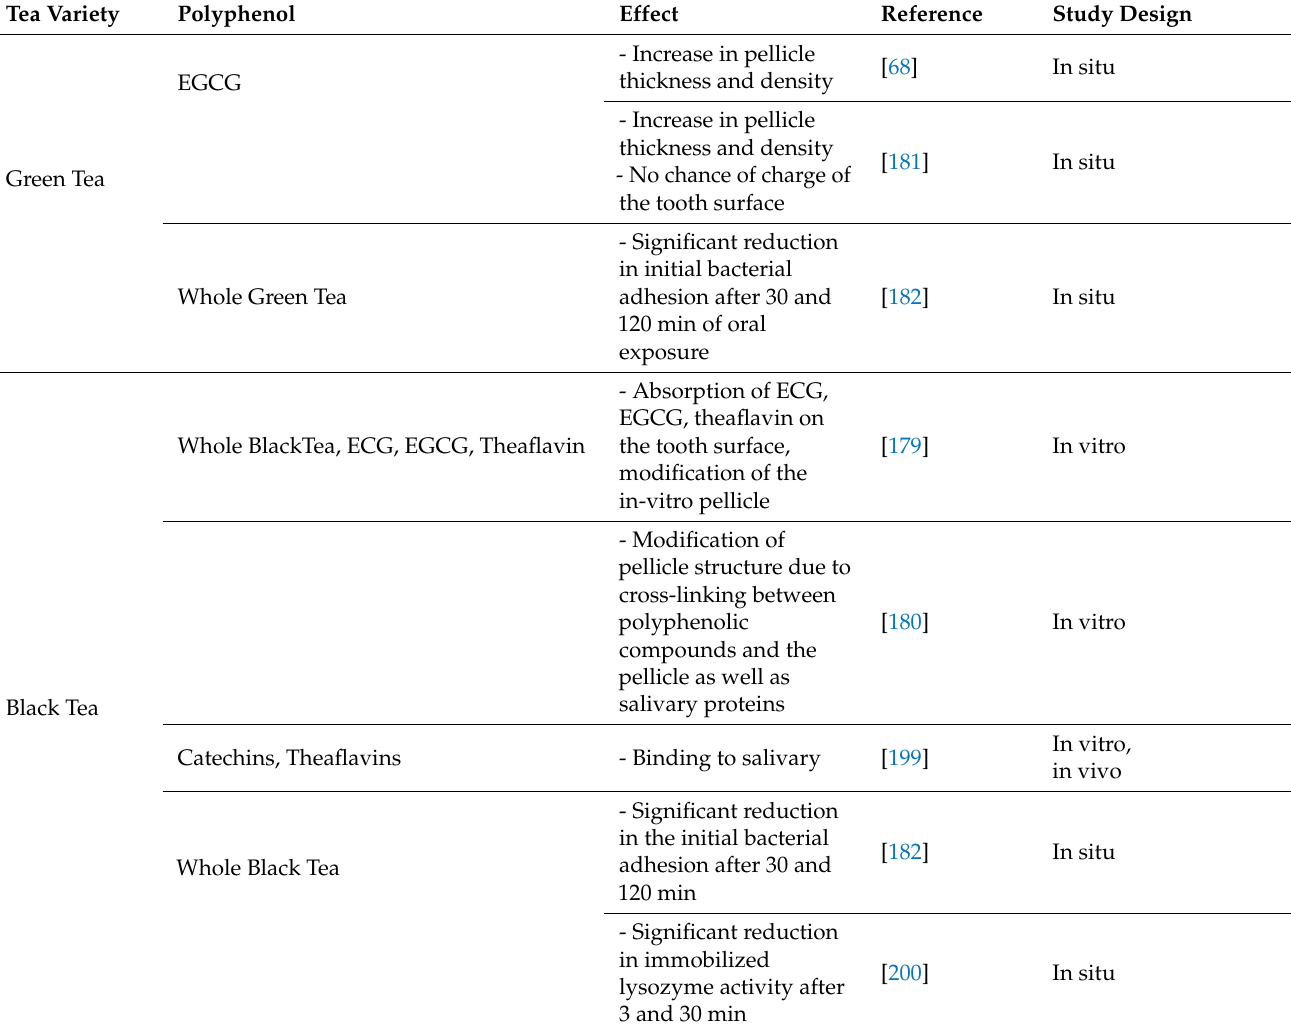
Table 2. Comparison of different tea polyphenols and their effect on the tooth